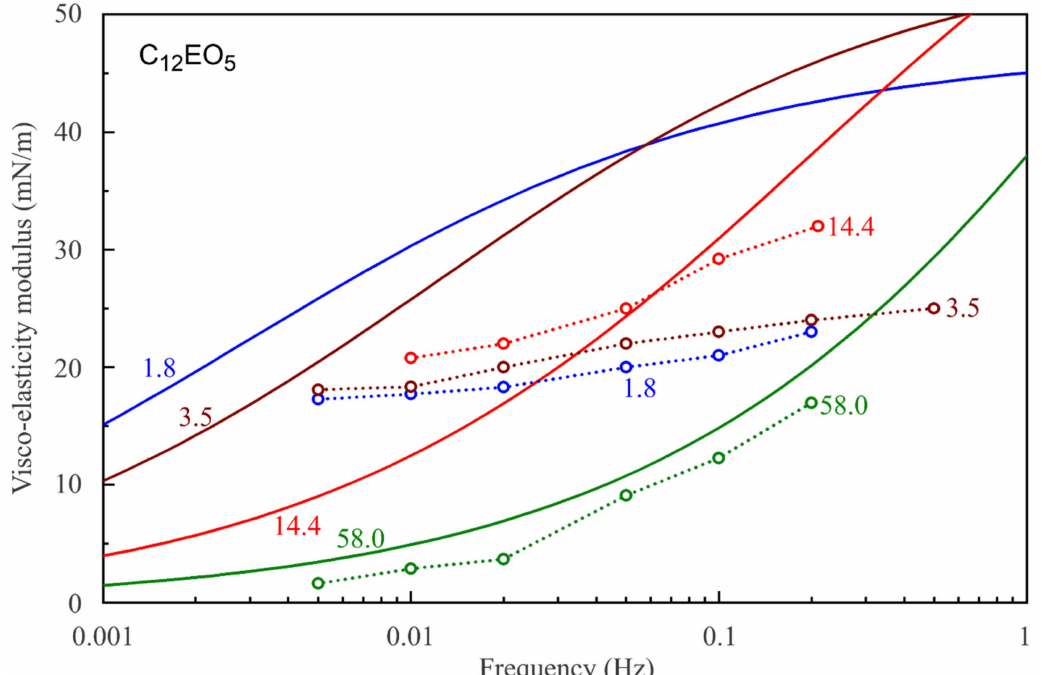
Figure 9. Experimental visco-elasticity modulus vs. frequency for C 12 EO 5 solutions of different concentrations (1.8, 3.5, 14.4, and 58.0 µ mol/L, as indicated by numbers) and the respective theoretical curves calculated with the LvT equation, Equation (8), with E 0 (c) and ω D (c) calculated by using the reorientation model, Equations (1)–(6), with the parameter values presented in Table 1. Dotted lines are guides for the eye.